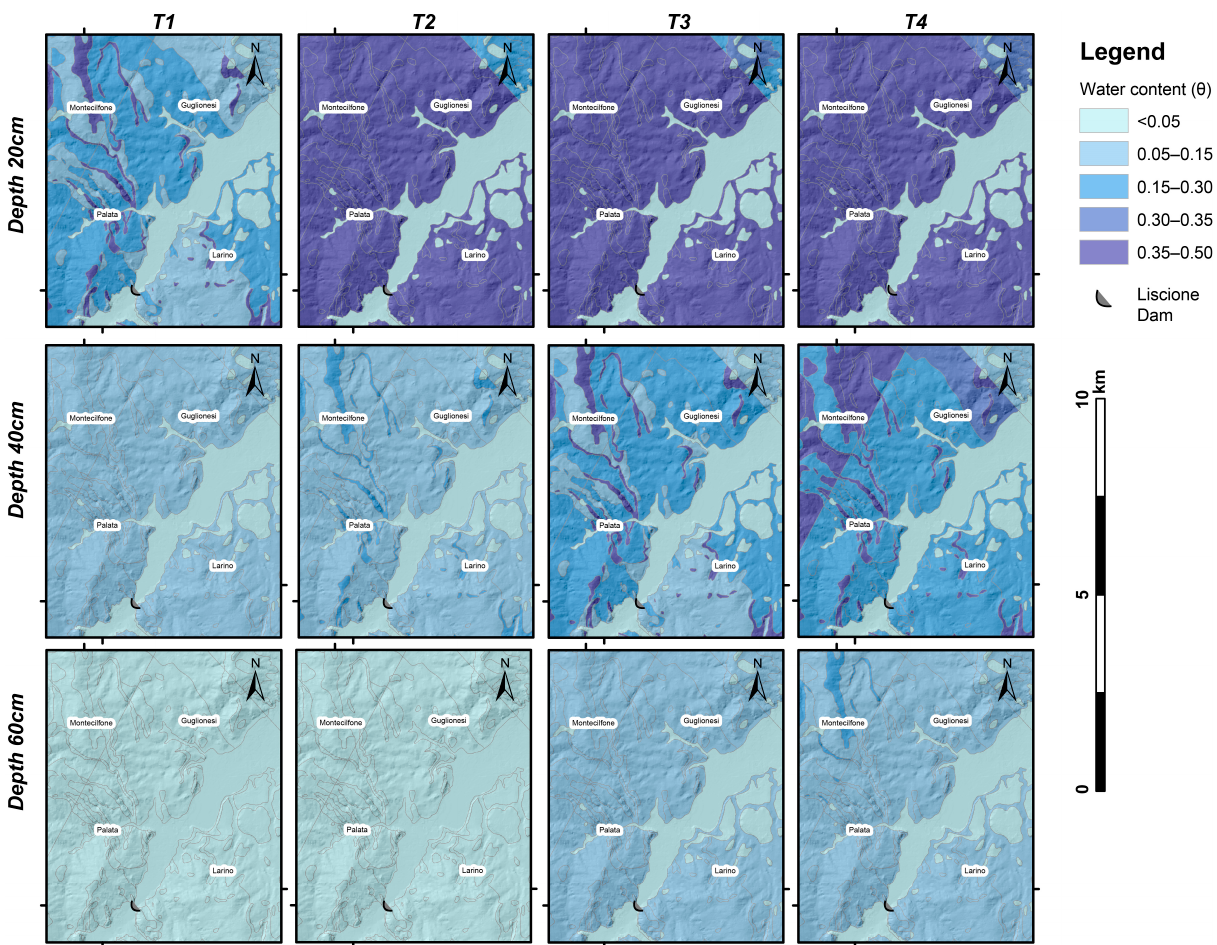
Figure 6. Maps show the variation of the water content at different depths over time within the shallow altered soil